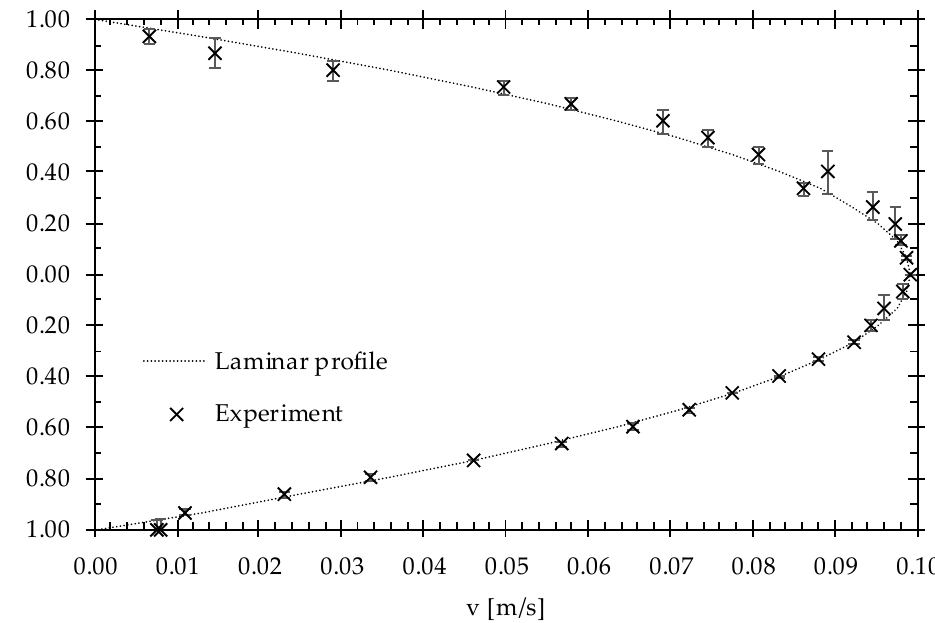
Figure 8. A comparison between laminar velocity profile Equation (5) and the experimental results with marked differences between radial distances.